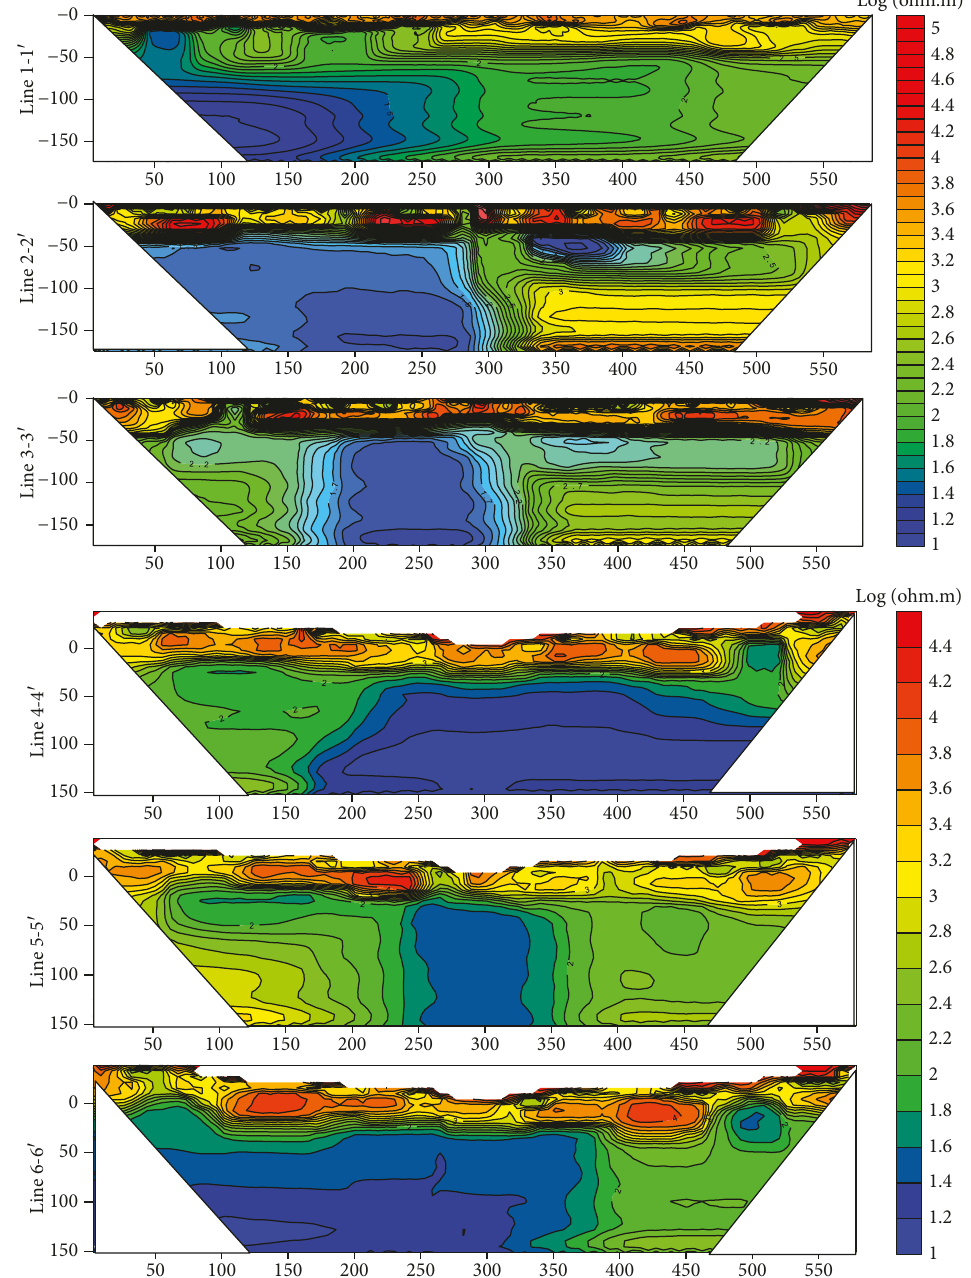
Figure 10: The results of high-density resistivity method